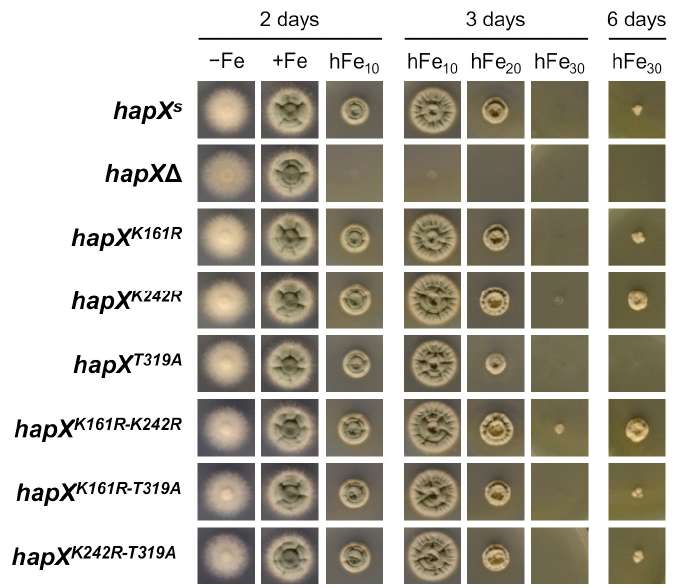
Figure 7. Mutations in HapX K161, K242 and T319 affect iron resistance. Growth of the indicated strains on solid AMM − Fe (iron depletion), +Fe (30 µ M FeSO 4 ), and hFe (10, 20 or 30 mM FeSO 4 ). Plates were incubated for the indicated time periods at 37 ◦